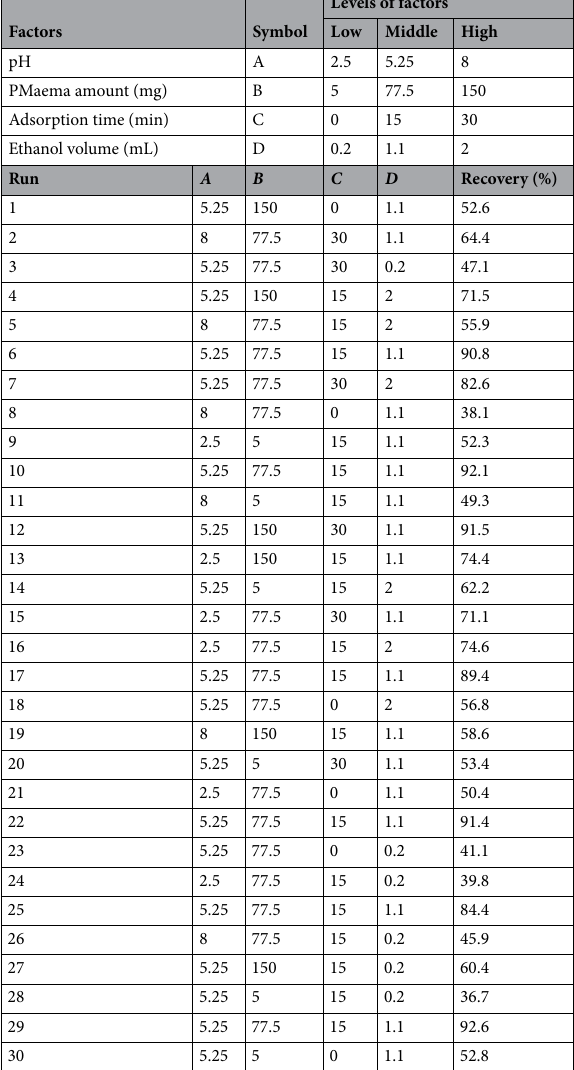
Table 11. Factors their symbols levels design matrix and results in the BBD to evaluate the microextraction